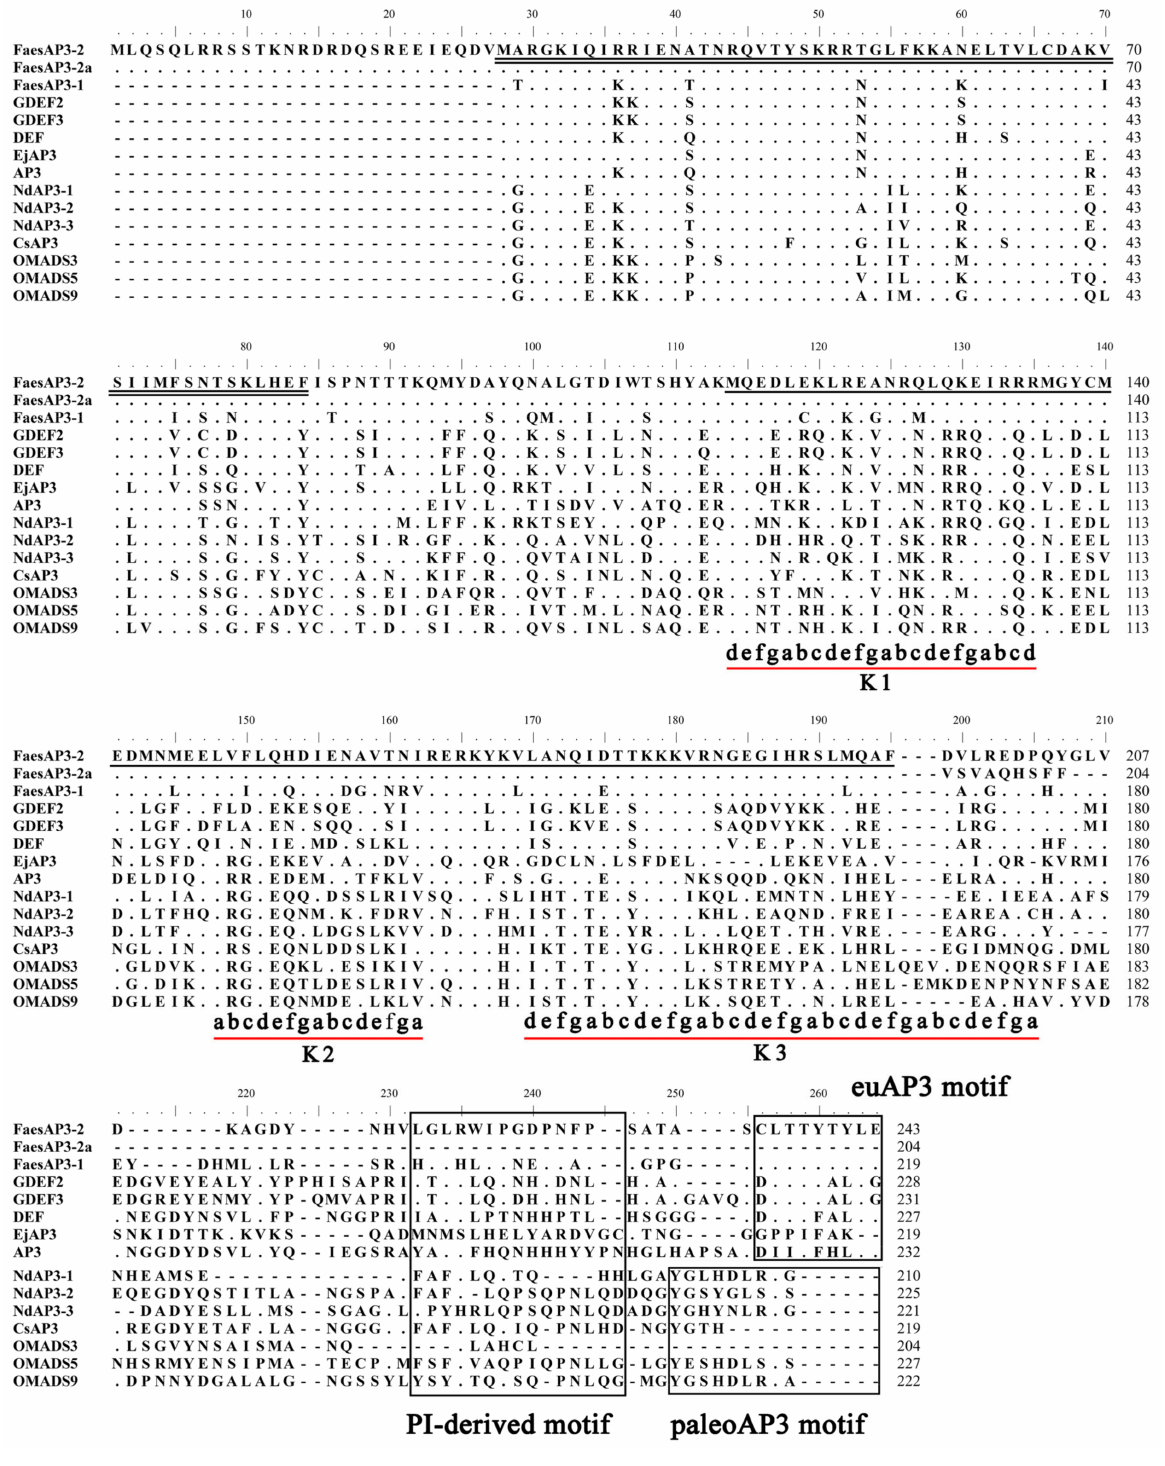
Figure 4. Sequence alignments of FaesAP3_2 and FaesAP3_2a with other AP3 -like proteins from different clades of an- giosperms. The double black underline represents the MADS domain and the single black underline the K domain. The conserved PI-derived motif, euAP3 motif and paleoAP3 motif located at the various C-terminal regions are boxed. The dots represent identical amino acid residues with FaesAP3_2 . Dashes introduced into the sequence to improve the alignment. Three red underlines represent k1, k2 and k3 subdomains with (abcdefg)n repeats and usually with hydrophobic amino acids at positions a and d